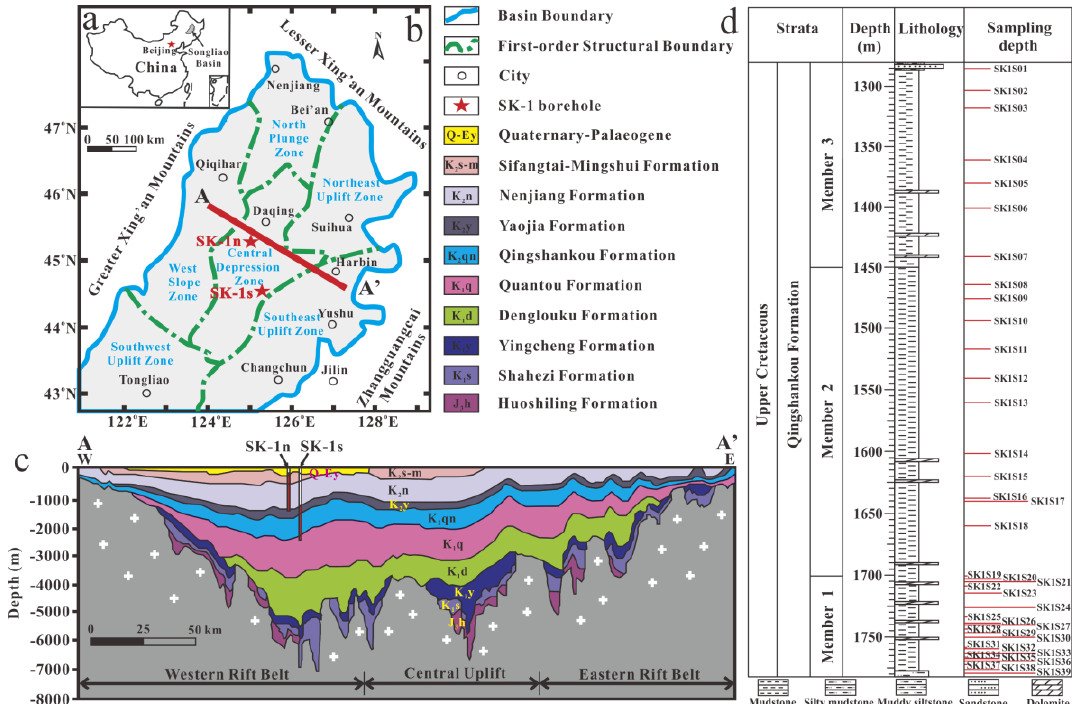
Figure 1. ( a ) Location map of the Songliao Basin (modified after [41]); ( b ) major structural zones in the Songliao Basin (modified after [41]); ( c ) structural cross-section across the central part of the Songliao Basin (modified after [46]); and ( d ) stratigraphic histogram of Qingshankou Formation in the SK-1s well (modified after [43]) and sampling depths.